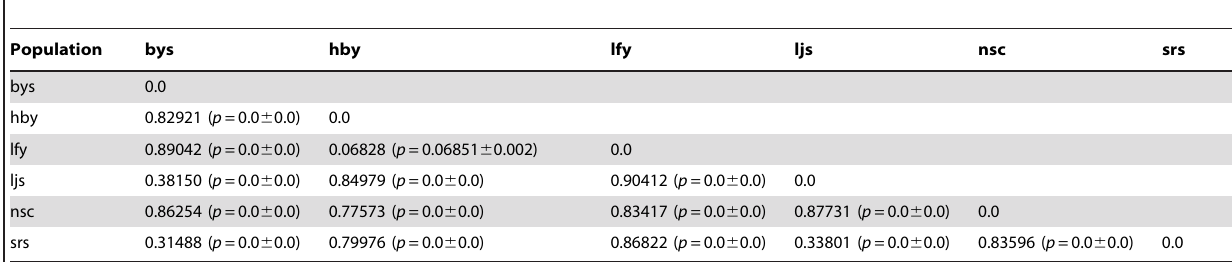
Table 4. F ST values between populations.